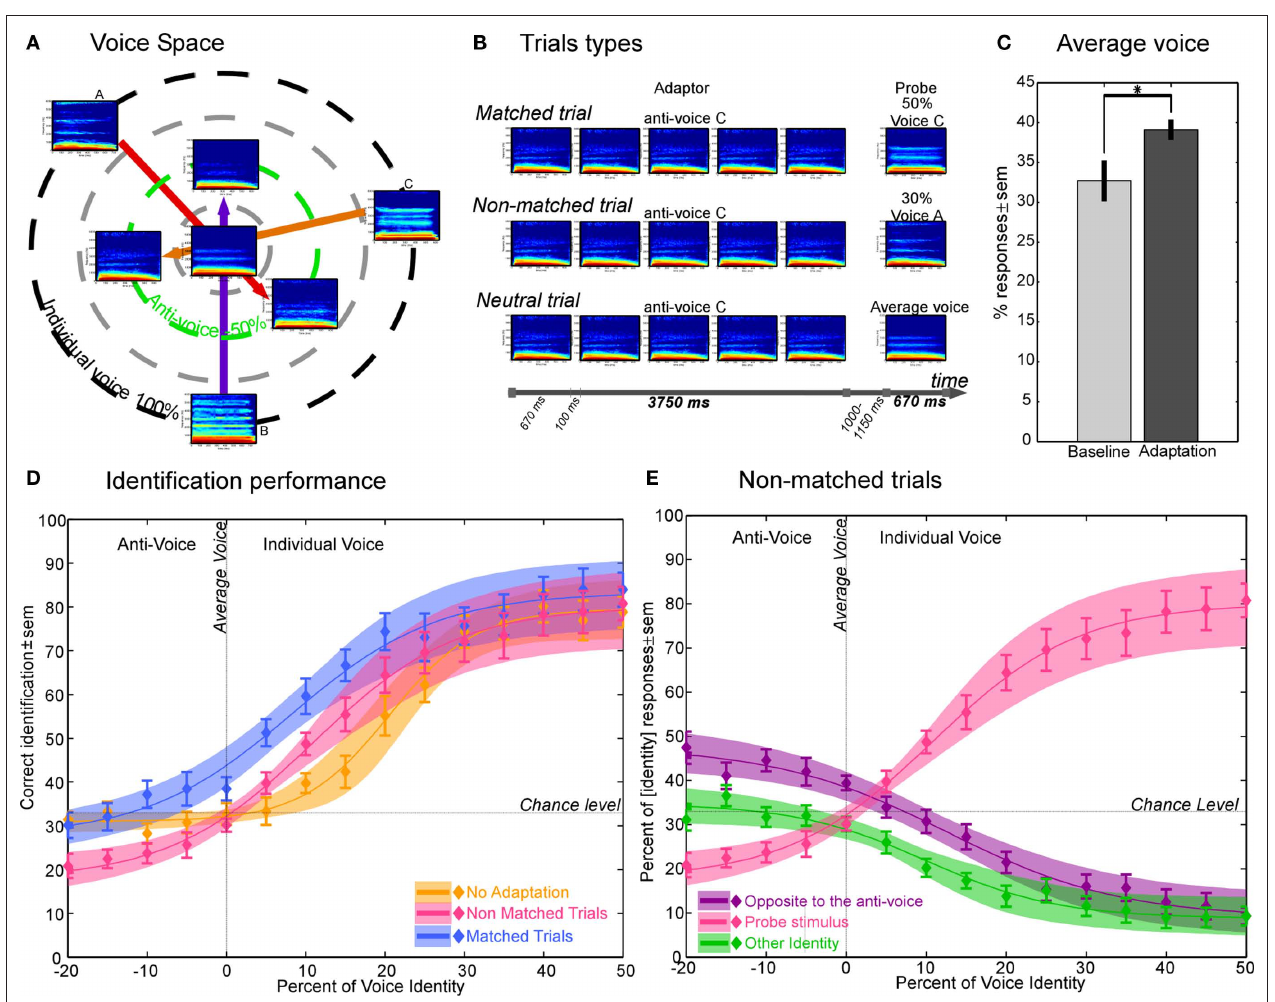
with a logistic function. Note greater aftereffects for matched (blue) than non-matched (pink) trials compared to the baseline (orange). (e) Response distribution in the non-matched trials. In the Y -axis definition (identity) refers to the legend: it can be identity-axis of the anti-voice (purple), the identity-axis of the probe stimulus (pink), or the other identity (green). For example, in a trial with adaptation to anti-voice A with probe stimuli drawn from the average voice B continuum: identity opposite to the anti-voice (purple) means the subjects answered voice A; identity of the continuum (pink) means the subjects answered voice B; other identity (green) means the subjects answered